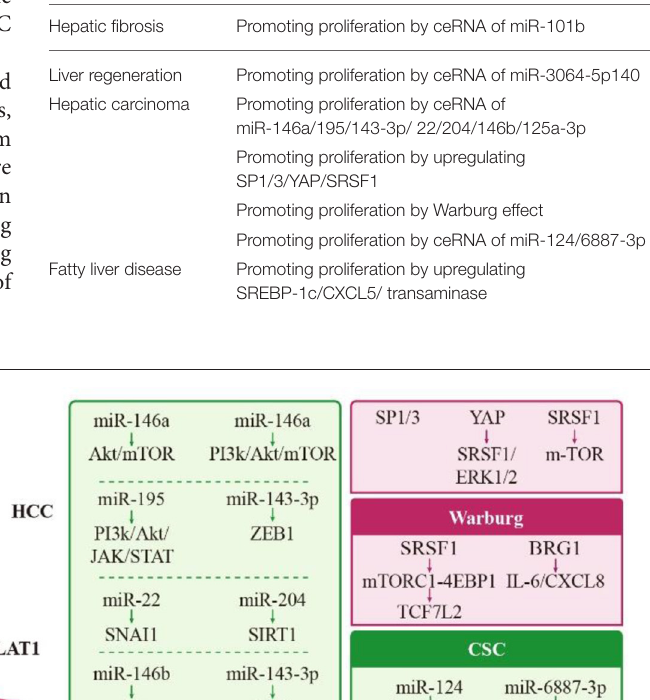
TABLE 1 | Different roles of MALAT1 under different liver diseases.